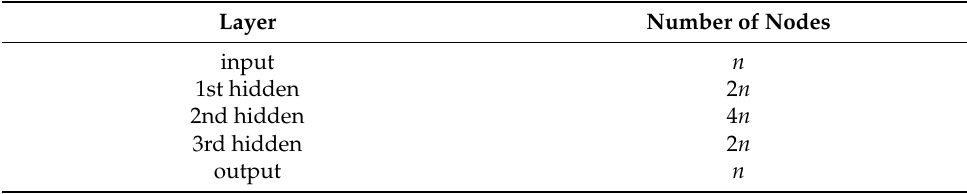
Figure 2. Structure of auto-decoder with 3 hidden layers. Table 2. Number of nodes for layers in